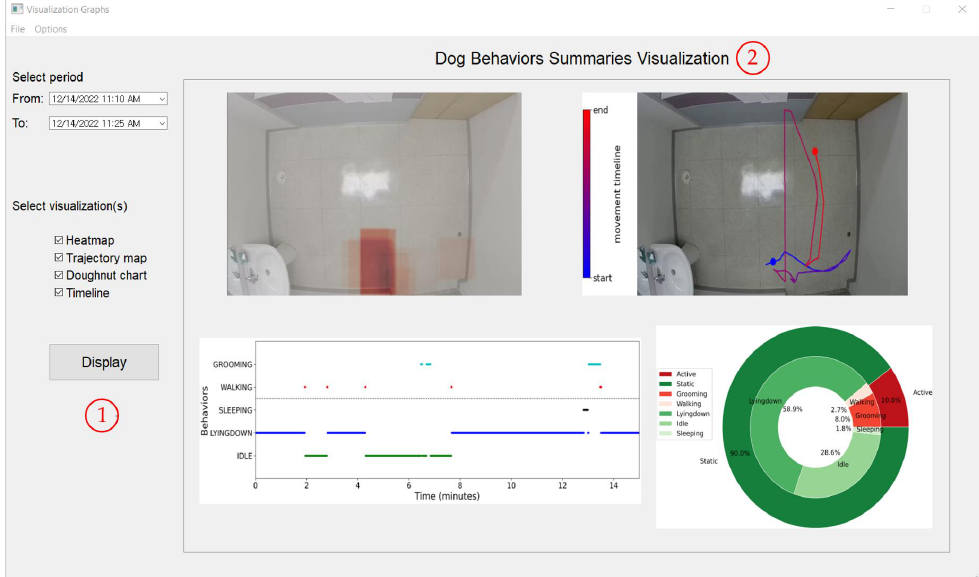
Figure 13. Secondary interface of the proposed system accessible through the main interface from Figure 12. 1 (cid:13) Controls used to select the period and visualization graphs to display; 2 (cid:13) the generated graphs of the behavior summarization to help visualize and understand the dog’s